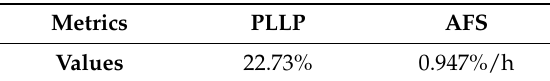
Table 12. Losses assessment result.